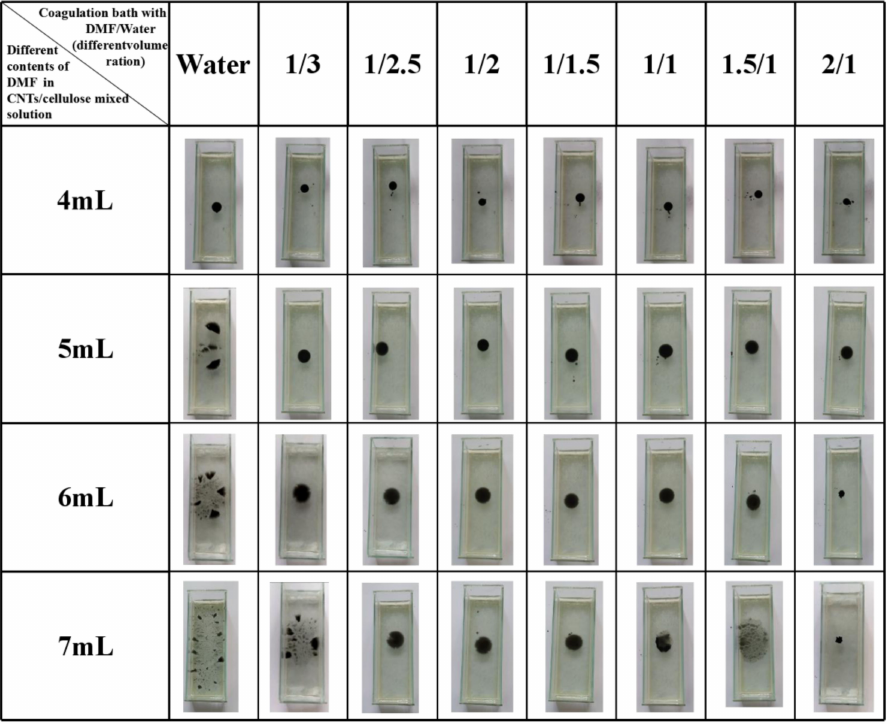
Figure 2. Digital photos of cellulose/CNTs mixed polymer solution added different DMF contents dropped into coagulating bath with DMF/water (different volume